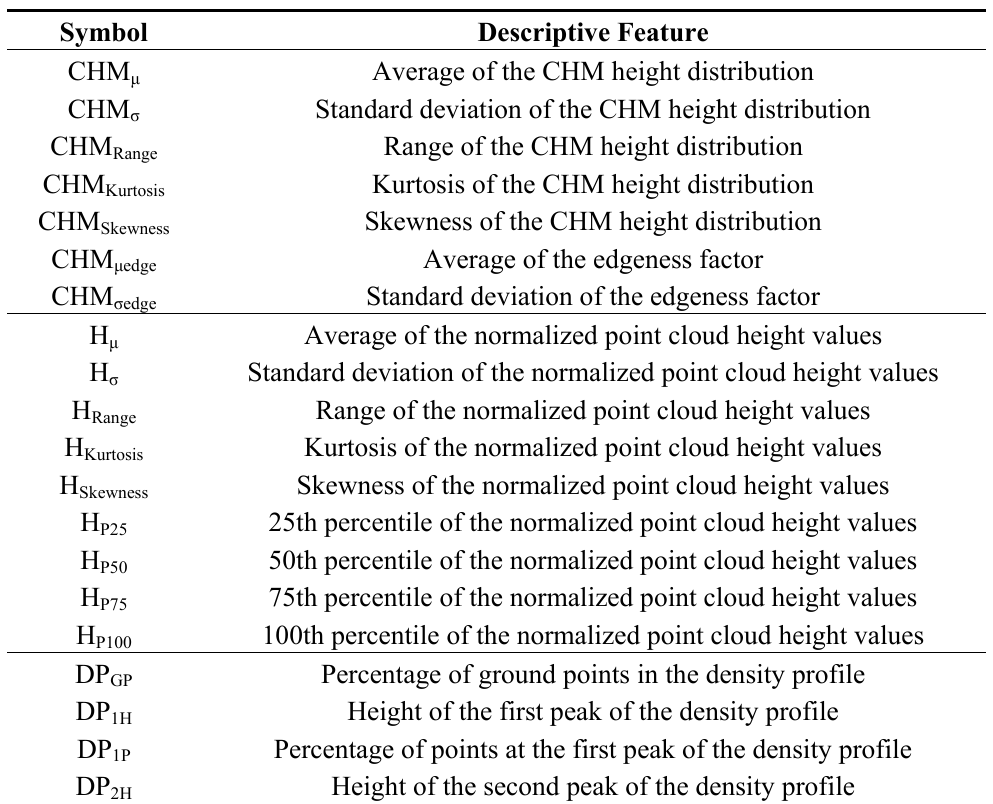
Table 3. Summary of the LiDAR based metrics